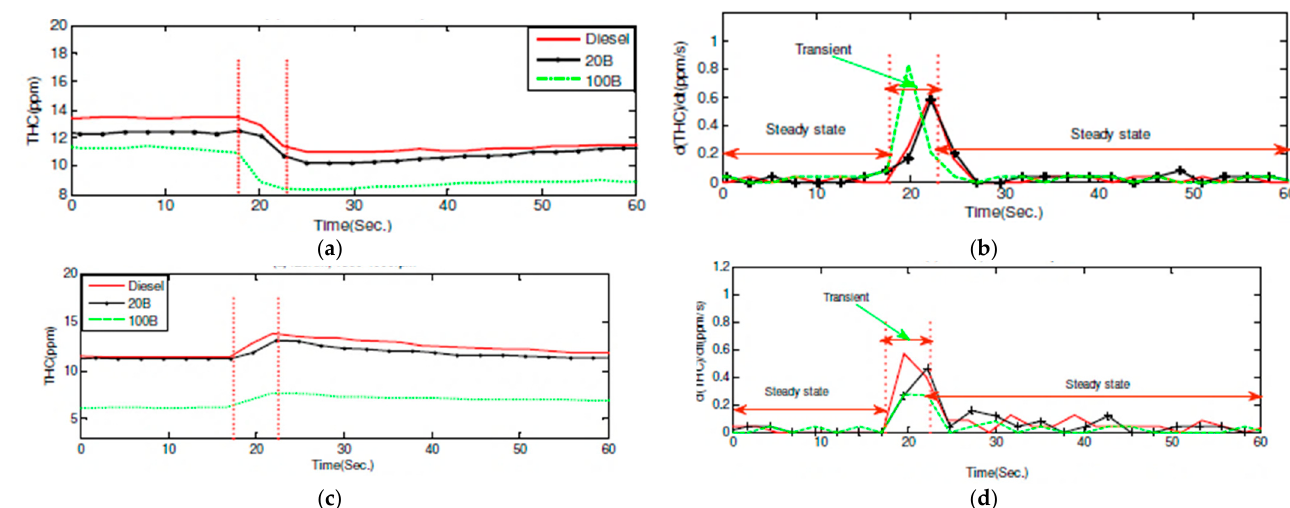
Figure 18. ( a ) THC emission in the engine with the three fuels during the negative speed transient at a torque of 420 Nm; ( b ) corresponding rate of change of THC emission. ( c ) THC emission in the engine with the three fuels during the positive speed transient at a torque of 420 Nm; ( d ) corresponding rate of change of THC emission.